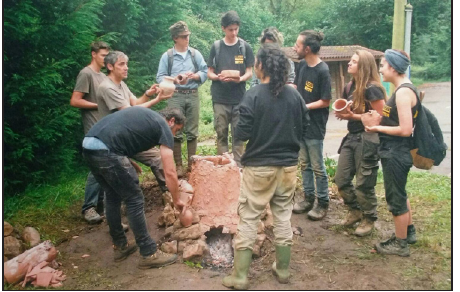
Figure 6: Students working with pottery